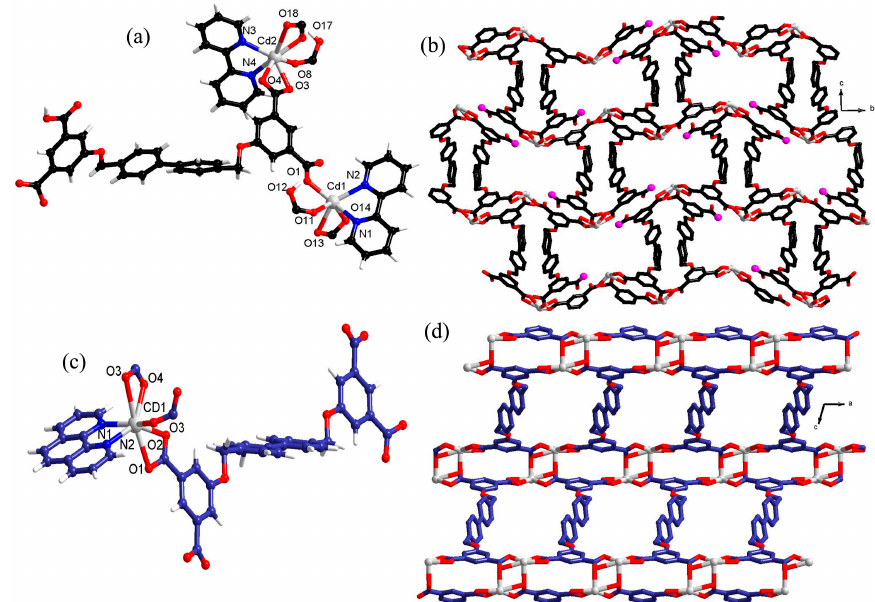
Figure 1. ( a ) The view of local coordination geometry of Cd(II) center and ligand in 1 . ( b ) The 2D layer in 1 as viewed slightly off the b axis. The hydrogen atoms have been omitted for clarity; the uncoordinated carboxyl groups pointing to the interior of pores (pink color). ( c ) The local coordination environment around Cd(II) in 2 . The hydrogen atoms have been omitted for clarity. ( d ) The 2D ladder-like layered architecture in 2 .